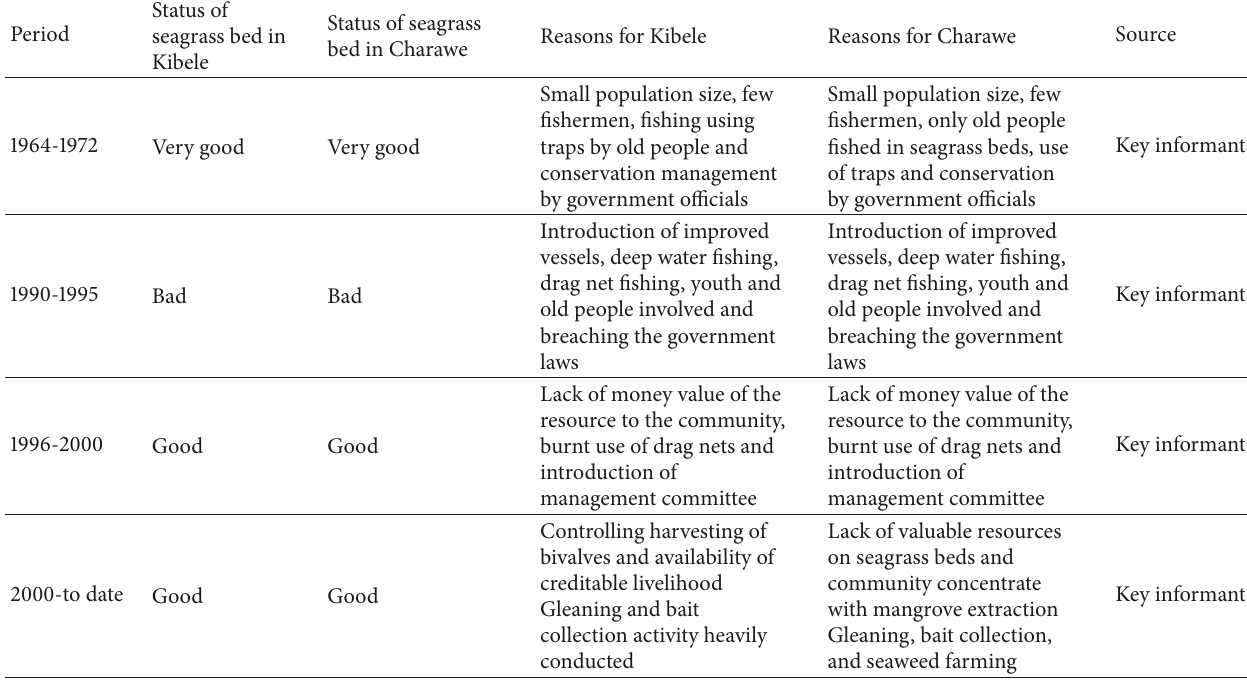
Table 3: Timeline analysis of seagrass status in Charawe and Kibele village since 1962 to date.